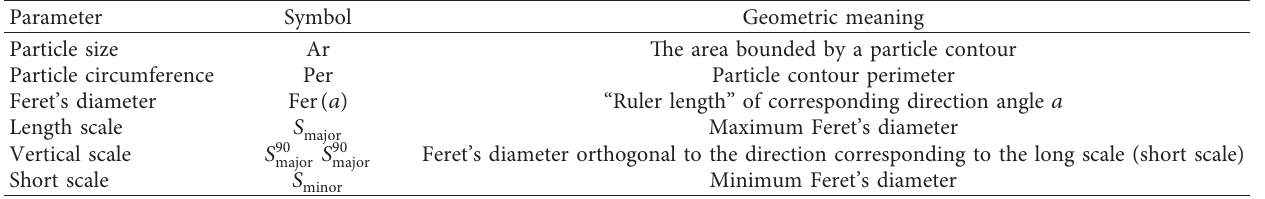
Figure 9: (a) Several bounding box of a particle; (b) the average bounding box. Table 1: Basic particle morphology indicators that are widely